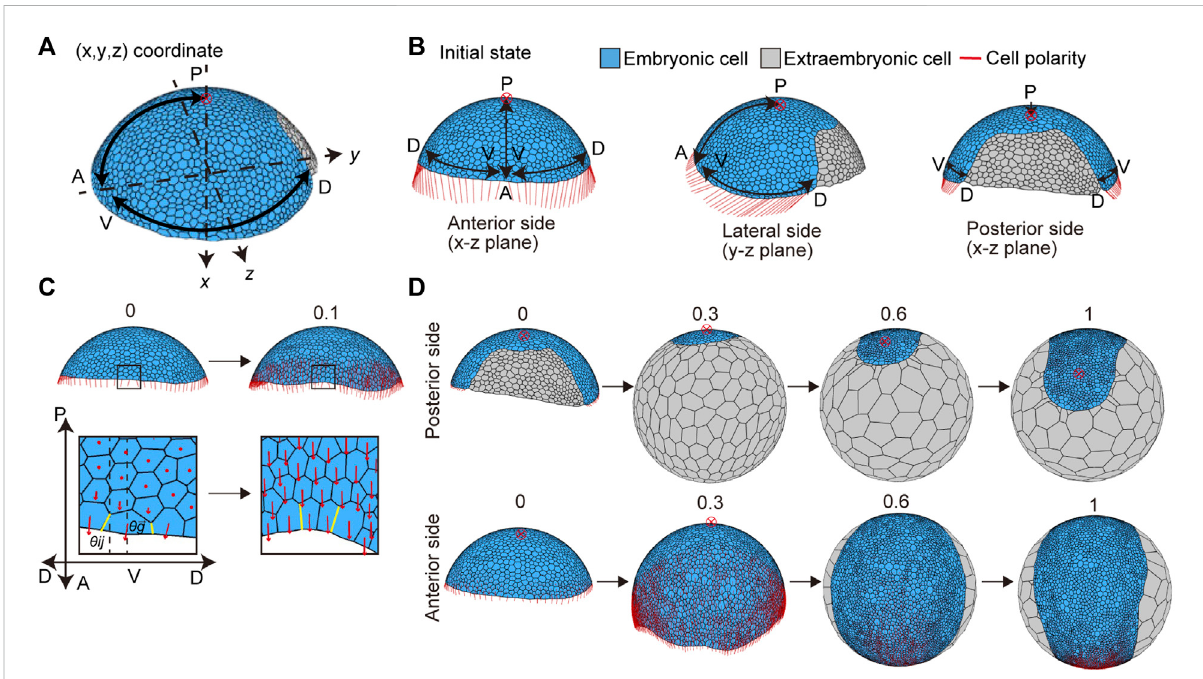
FIGURE 4 Initial settings for cell polarity and cell differentiation, and the deformation from the germ disc to germ band in silico . (A) Direction of two body axes(anterior – posterior (A-P)and dorsal – ventral (D-V) axes) de fi ned inthe germ disc.The A-Paxis ison thex-y plane, and theD-Vaxis ison they-z plane in the Cartesian coordinate system (x, y, z). The red cross with a circle indicates the position of a posterior pole in (A,B,D) . Embryonic and extraembryonic cells are depicted in blue and gray, respectively in (A,B,D) . (B) Initial setting for cell polarity, viewed from three different sides of the embryo: the anterior side (left), lateral side (center), and dorsal side (right). Initial cell polarities were only set in embryonic cells located at the rim of theembryo (redline). (C) Initial cell polarity de fi ned bythe initial directionof theA-P and D-V axes ( t =0, left),and changes inthe cell polarity over development are shown ( t = 0.1, right). The boxes in the embryo are magni fi ed in the lower panels. The strengths of cell adhesion tension change dependingondifferentanglesbetweencelledgeorientation(yellowline, θ ij )andthecellpolaritydirection( θ (cid:2) g ;seeinMethods). (D) Modelsimulation n overtime.Initialcellpolaritiesweresetasshownin (B) .Numbersoneachpanelrepresentthedevelopmentaltime.Thevirtualdisc-likecellassembly (blue) was deformed into a band-like shape, similar to that observed in P. tepidariorum